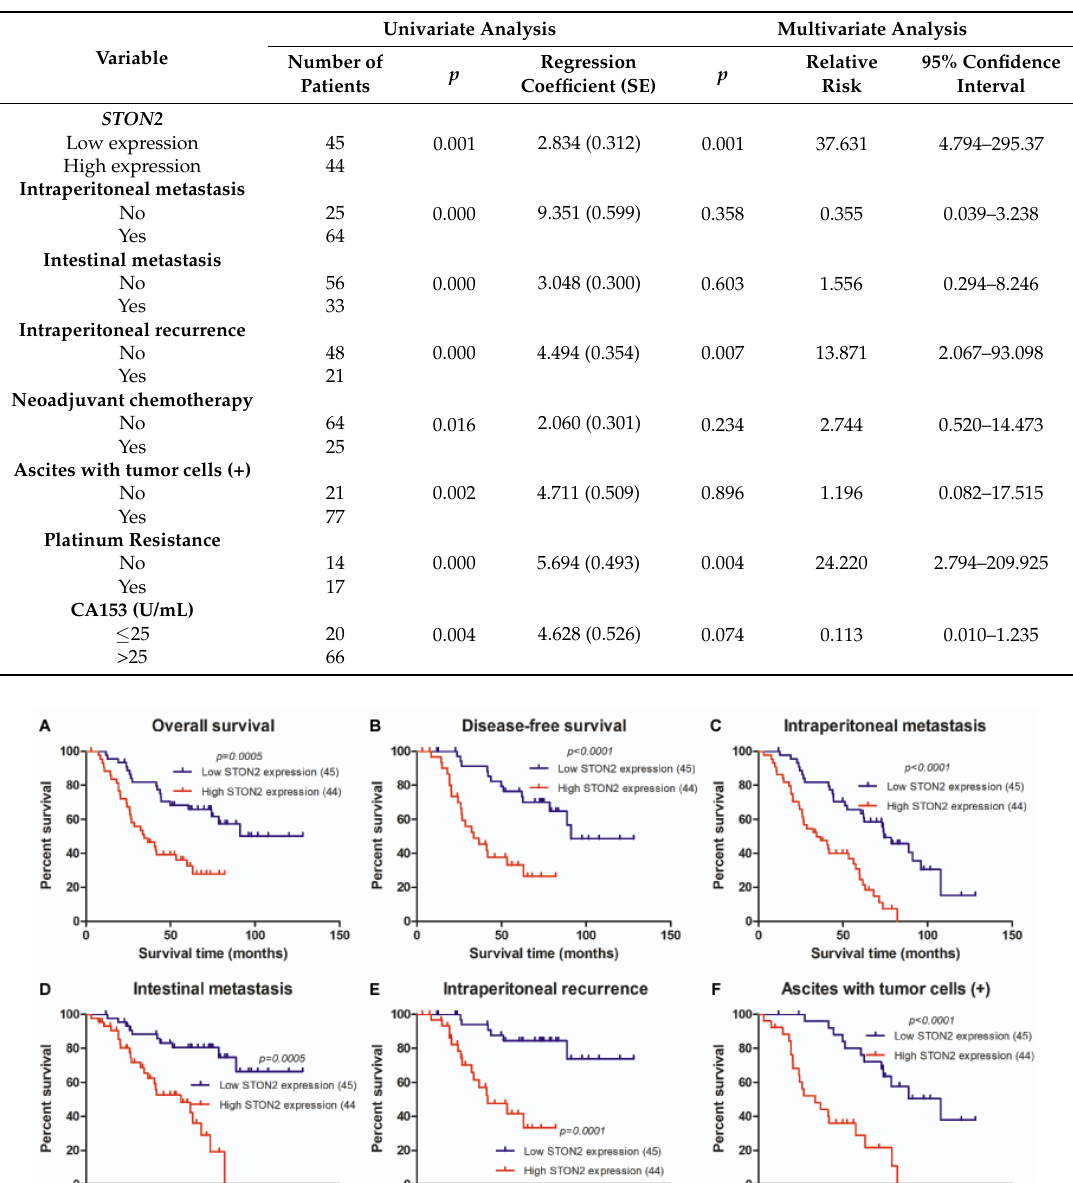
Table 4. Cox regression univariate and multivariate analyses of prognostic factors in epithelial ovarian cancer.